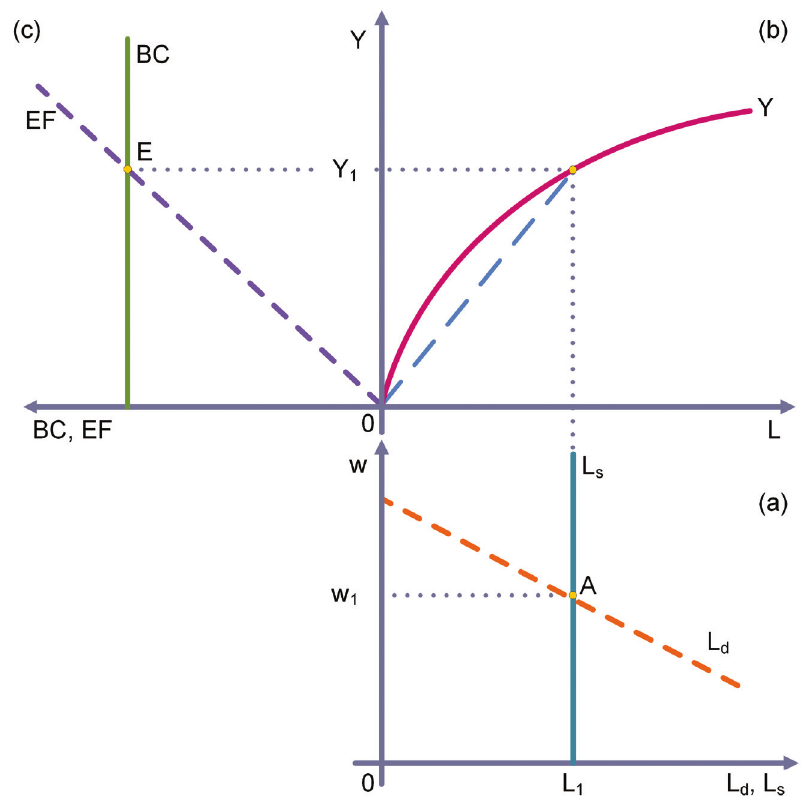
Figure 1: A steady state economy in long-run